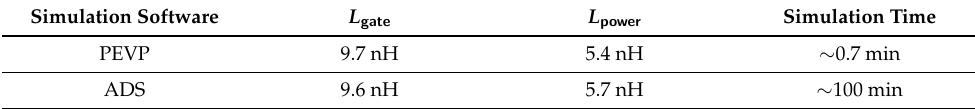
Figure 5. GaN-HEMT half-bridge circuit prototype and its models in PEVP: ( a ) Prototype. ( b ) Models in PEVP. ( c ) Obtained L para for power loop and gate loop. Table 3. Comparison between PEVP and ADS for parasitic inductance value